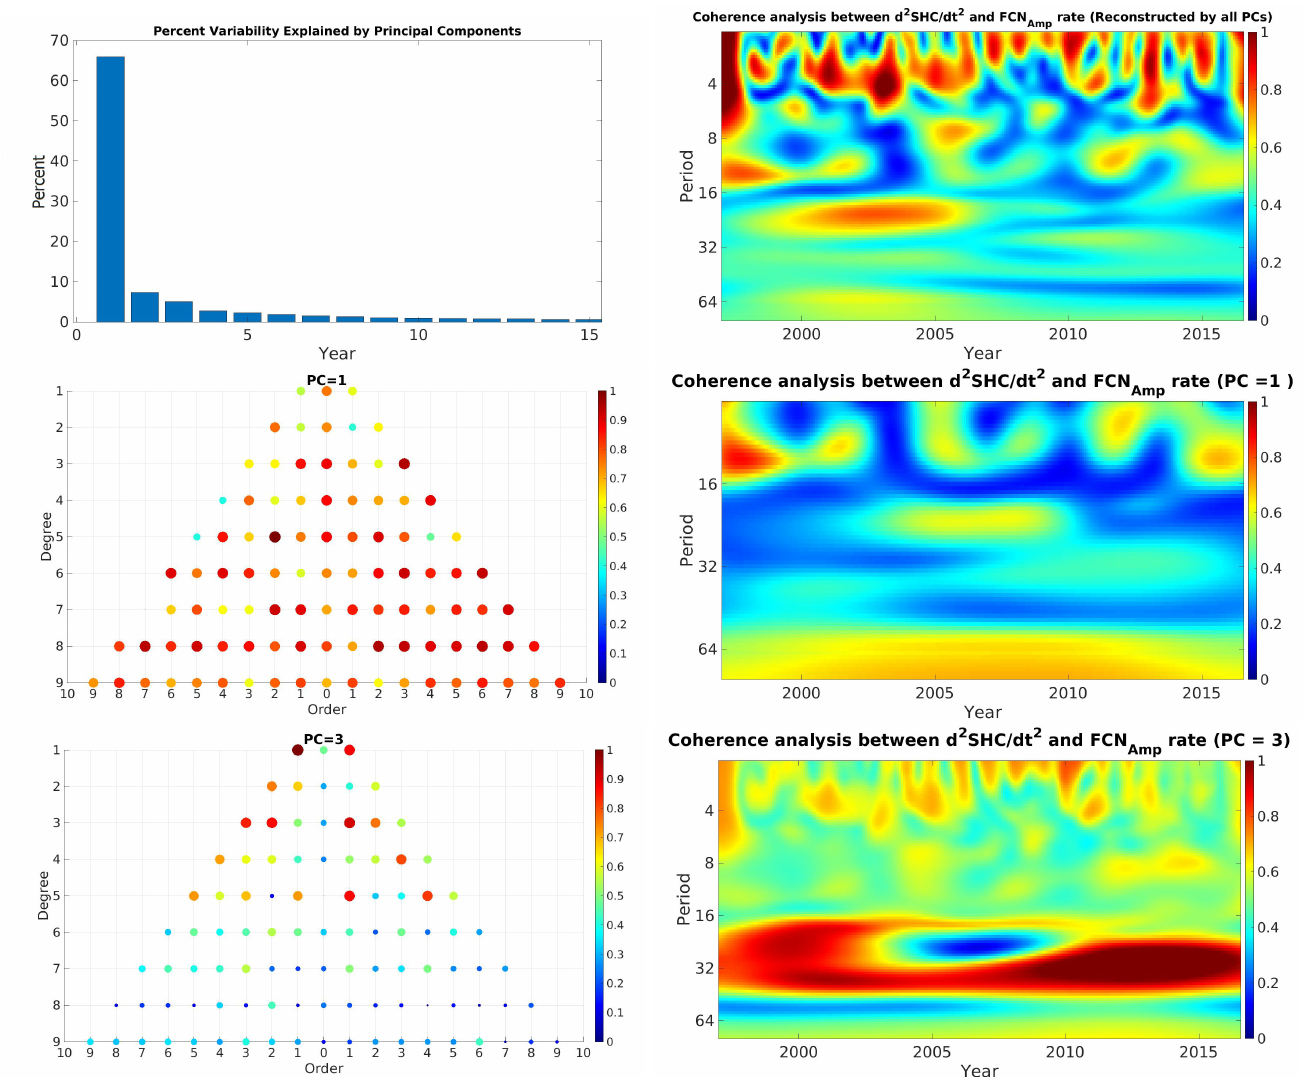
Figure 6. Wavelet coherence analysis between all SHC of GMF and FCN Amp rate (upper panel) and the percentage of each PC. Middle left panel: SHC correlation with the first PC. Middle right panel: the coherence between GMF and FCN Amp rate reconstructed by PC = 1. Lower left panel: SHC correlation with the PC = 3. Lower right panel: the coherence between GMF and FCN Amp rate reconstructed by PC = 3. Unit of periods is